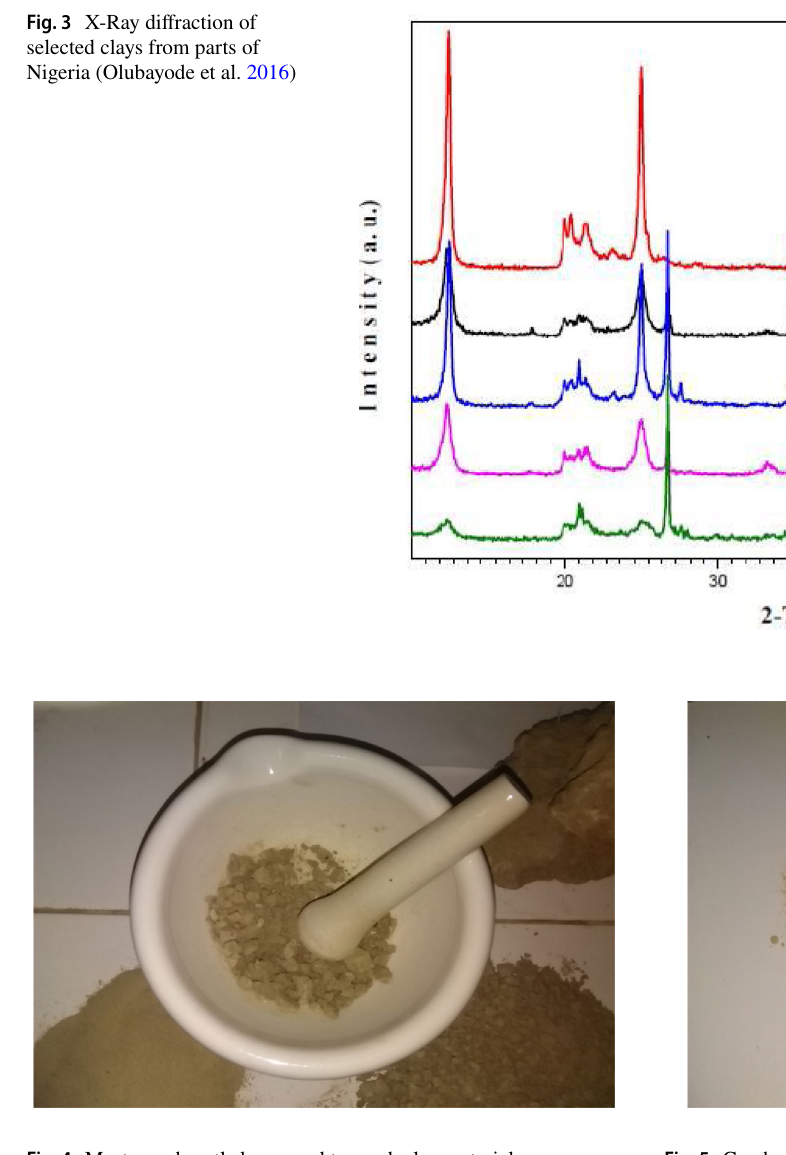
Fig. 4 Mortar and pestle been used to crush clay